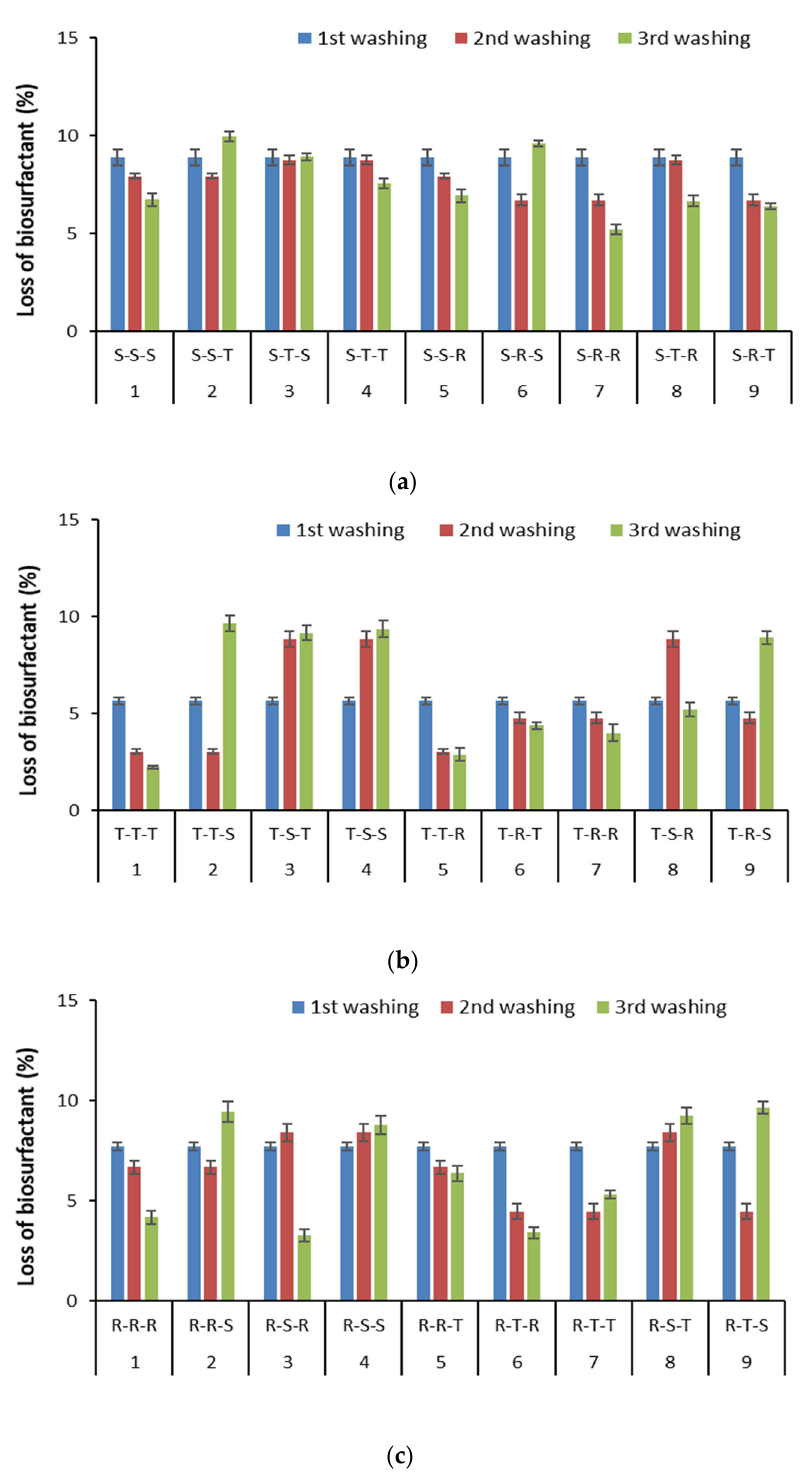
Figure 8. Estimation of biosurfactant loss after individual soil washing using specific biosurfactant sequence: ( a ) saponin variant, ( b ) tannic acid variant, ( c ) rhamnolipids variant (mean ± SD, n = 2).